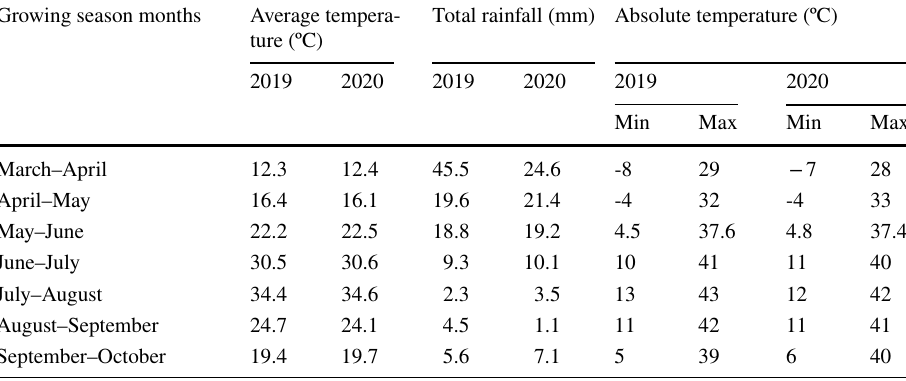
temperature and rainfall during the growing season in the